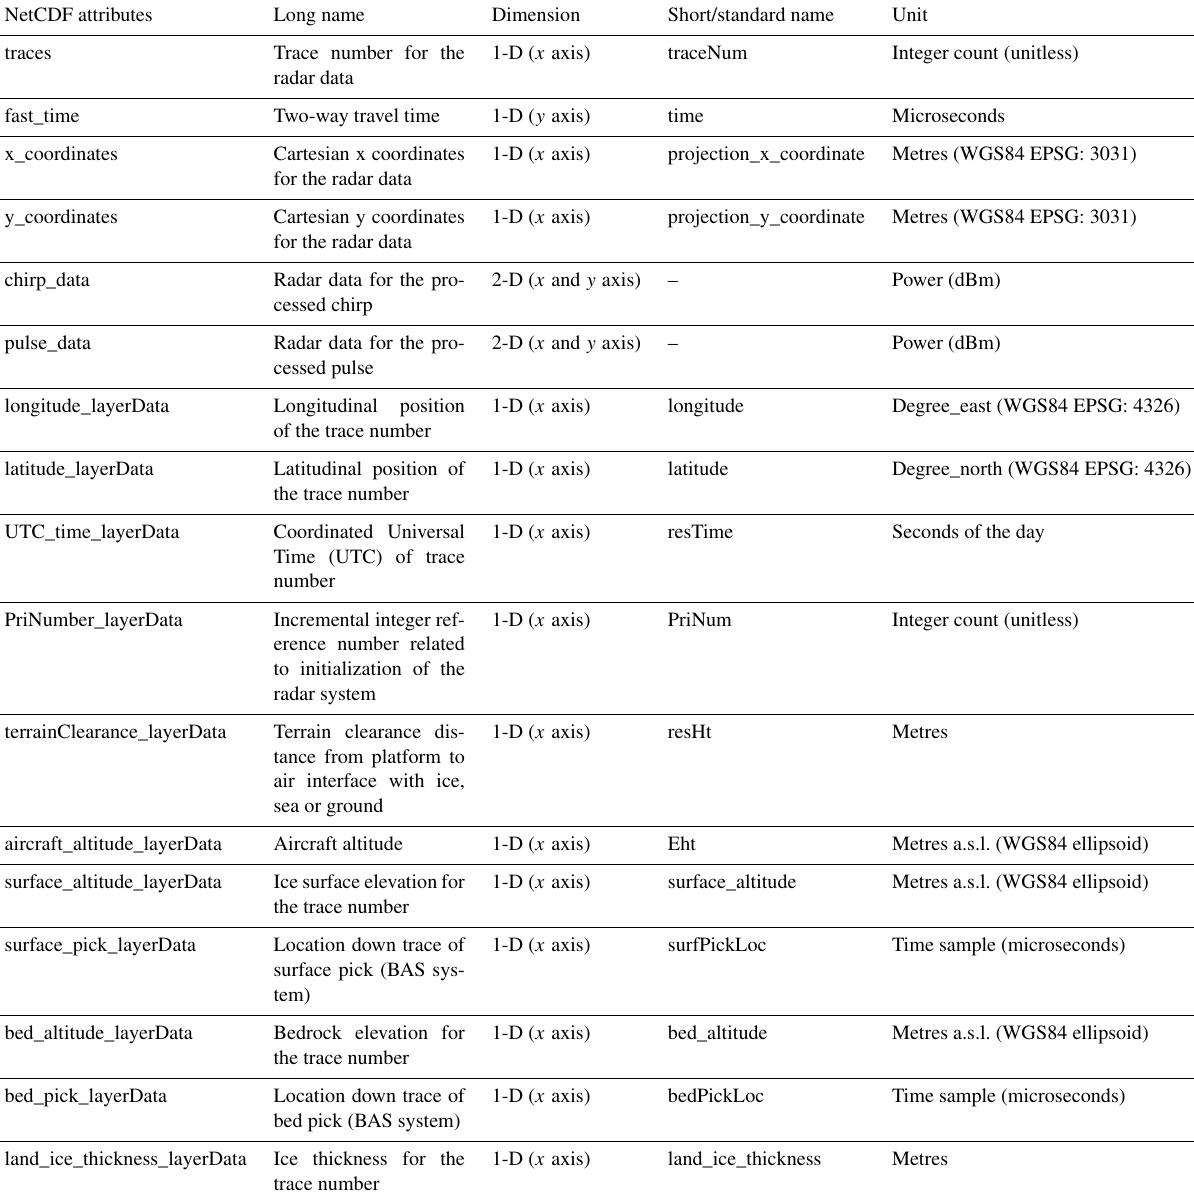
Table 4. Attributes for each variable stored in the NetCDF files. For each attribute name, we provide the long name, the dimension (1- or 2-D, x or y axis), the short or CF-compliant standard name, and the unit of the measurement. The standard name is only provided if it exists as part of the CF convention (https://cfconventions.org/, last access: 18 July 2022), otherwise a short name is provided. The abbreviation “dBm” stands for decibel-milliwatts and “a.s.l.” stands for above sea level. Note that the surface and bed-pick data are referenced to the sampling time of the BAS radar systems across the 64µs pulse repetition interval window, and digitized according to the receiver sampling frequency (see Table